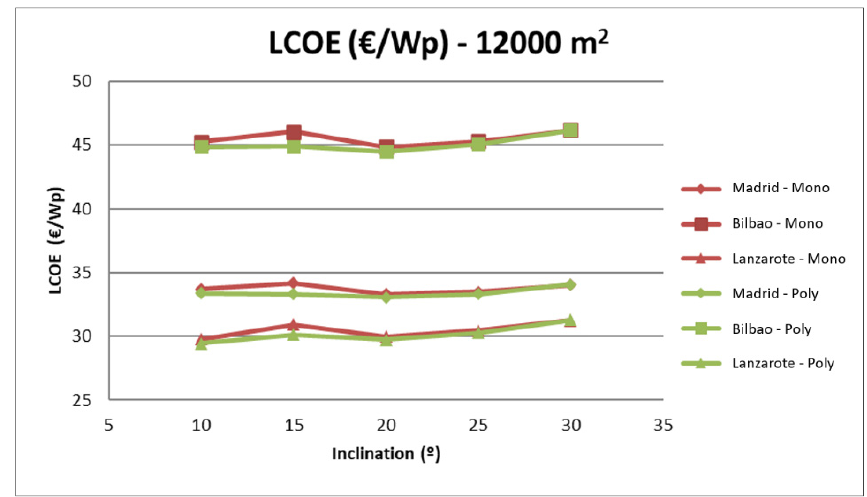
Figure 15. LCOE variation as a function of inclination.